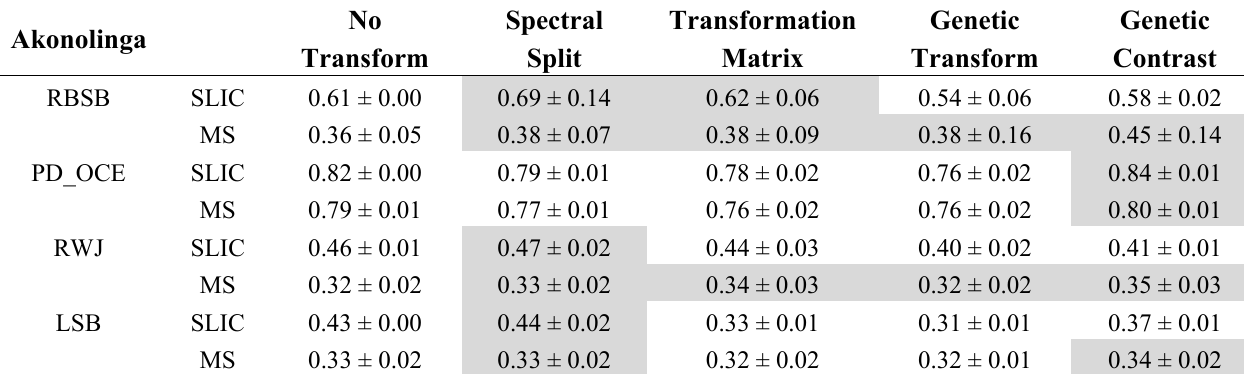
Table 5. Akonolinga site